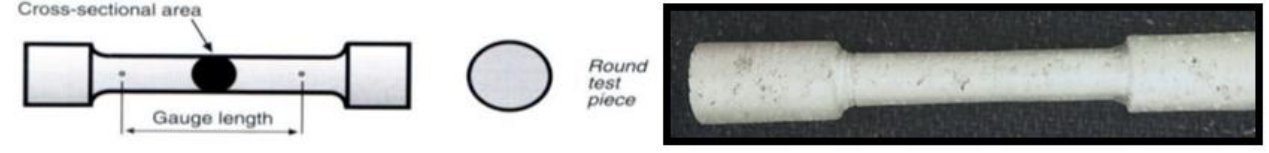
Figure 5. Tensile test samples.